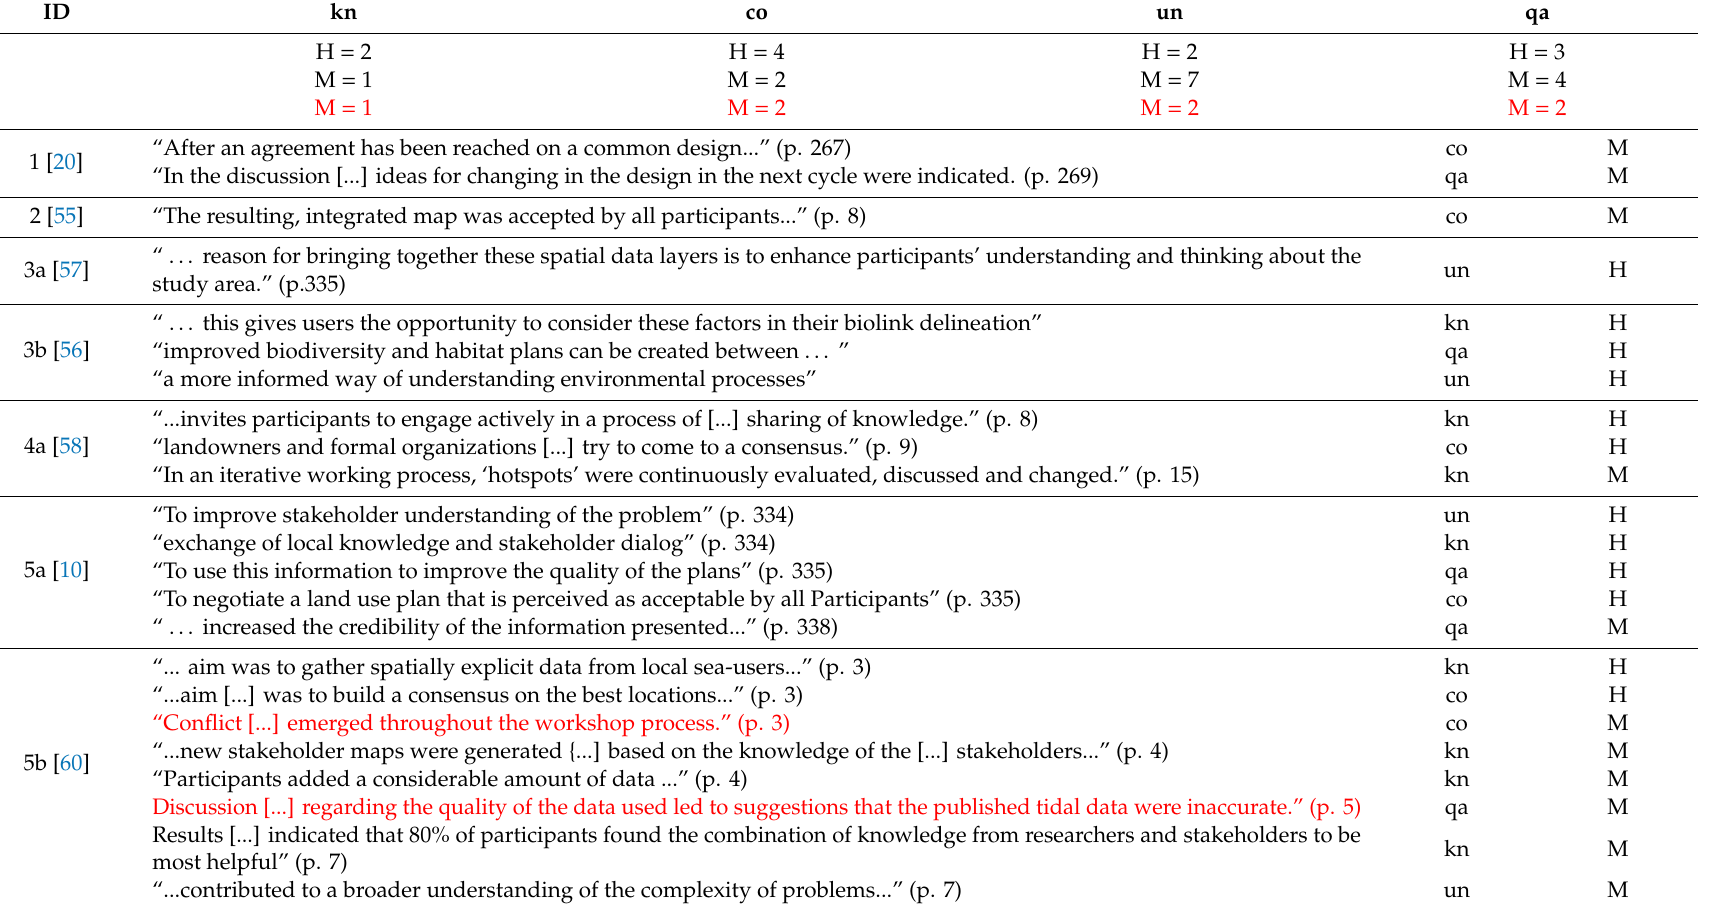
Table A6. Issue related